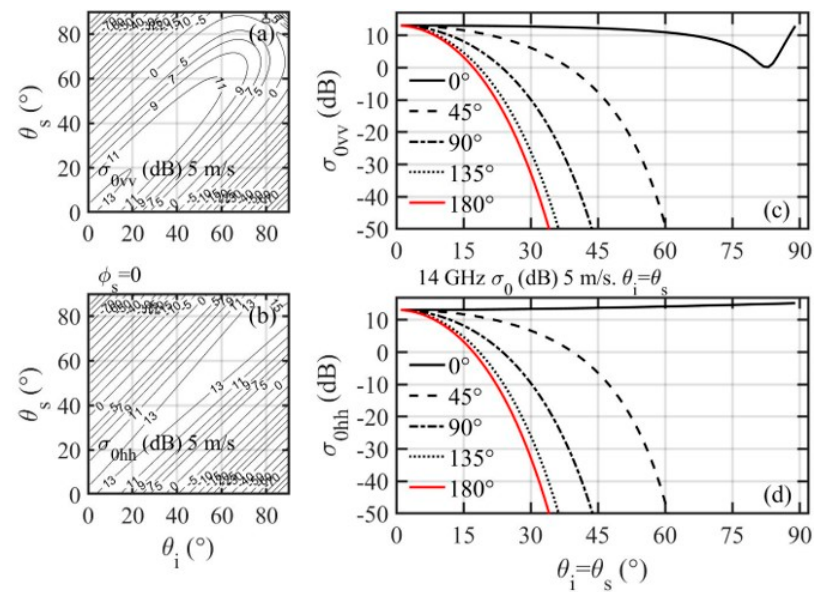
Figure 13. Examples of NRCS dependence on incidence and scattering angles. In-plane forward scattering ( ϕ s = 0°): ( a ) vv , ( b ) hh . Variation of NRCS along θ i = θ s for ϕ s = 0°, 45°, 90°, 135°, and 180° scattering azimuth angles: ( c ) vv , ( d ) hh . The microwave frequency is 14 G Hz and wind speed is 5 m/s.